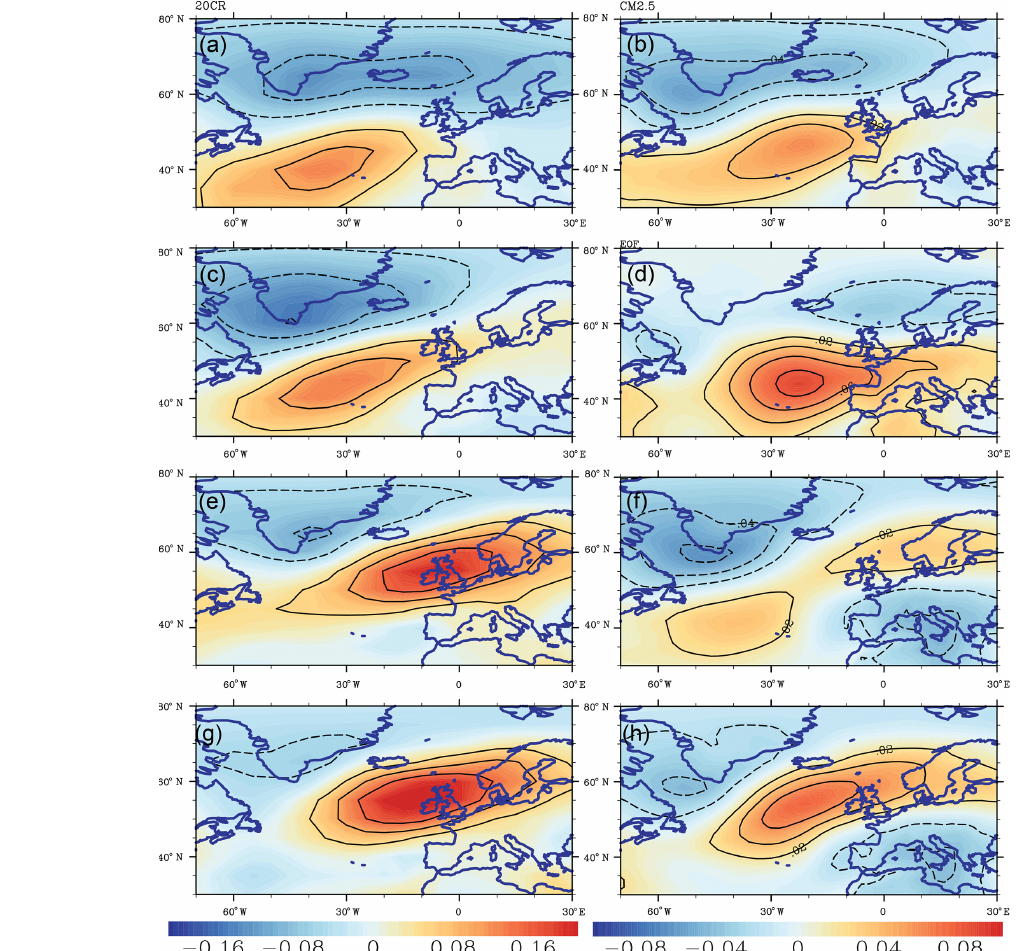
Figure 5. Spatial pattern of the SNAO (EOF) derived from the 20CR reanalysis (a, c, e, g) and from the first CM2.5 HIST run (b, d, f, h) , shown as correlations between the first principal component time series and SLP in July–August. The pattern is derived from the periods (a, b) 1870–1920, (c, d) 1900–1950, (e, f) 1940–1990, and (g, h) 1960–2010. Please note that the sign of each derived EOF is arbitrary. The analysis took this fact into account and unified the sign, showing the SNAO at its positive